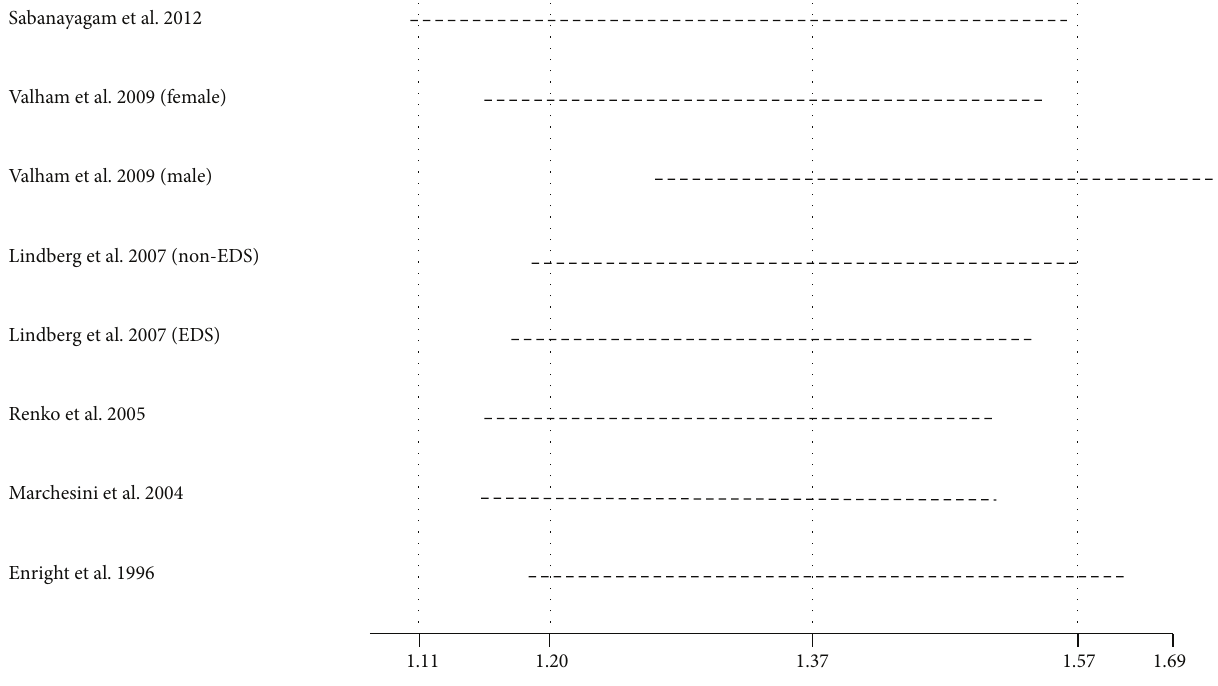
one study was conducted in a female population [21]. In the female population ( 𝑛 = 12298 ), the pooled OR was 1.59 (95% CI, 1.20–2.11), whereas OR = 0.89 (95% CI, 0.65–1.22) in the male population ( 𝑛 = 4276 ) [18,